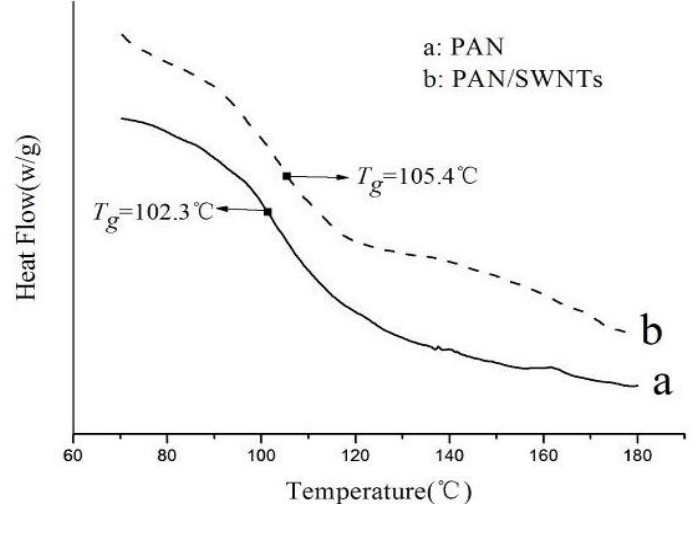
Figure 4. DSC curves of electrospun nanofibers: (a) PAN nanofibers; (b) PAN/SWNTs composite nanofibers with SWNTs concentration 1